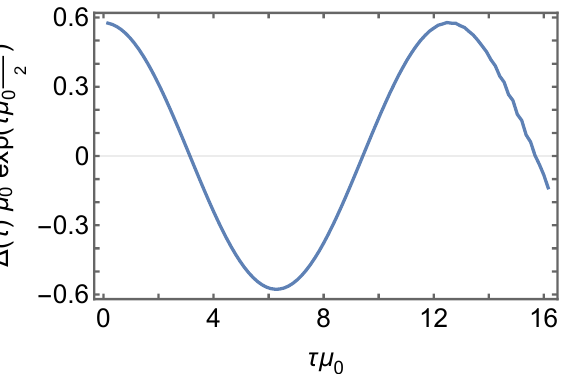
√ 3 ) computed from the Schwinger function in Equation (18) using 2